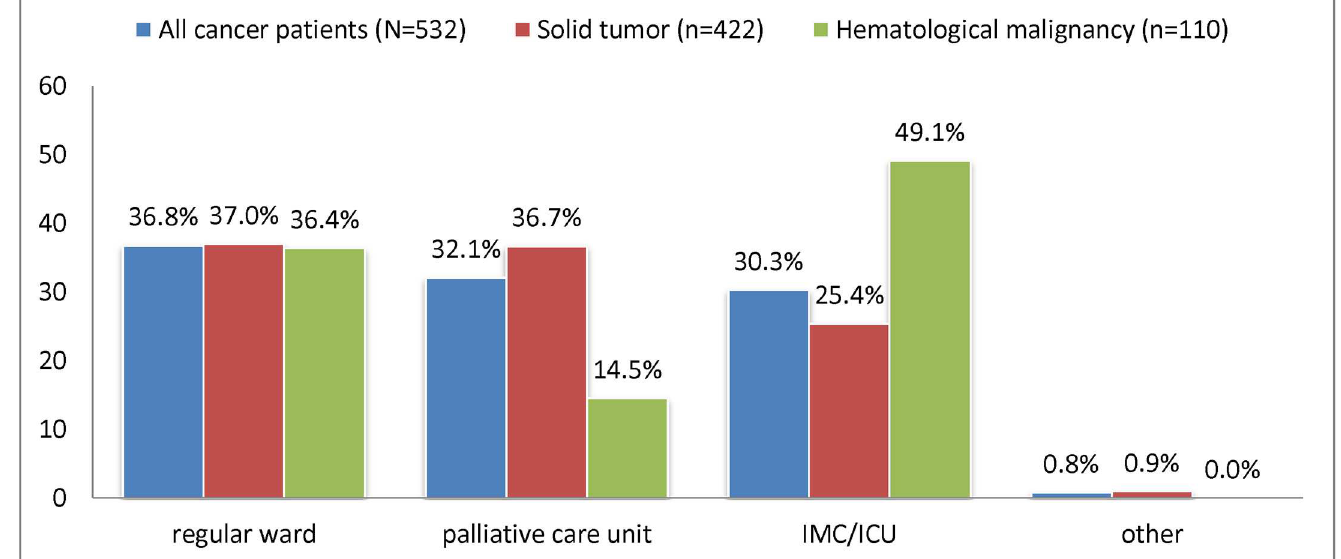
Fig 2. Place of death in hospital for cancer patients. IMC = Intermediate Care Unit; ICU = Intensive Care Unit.